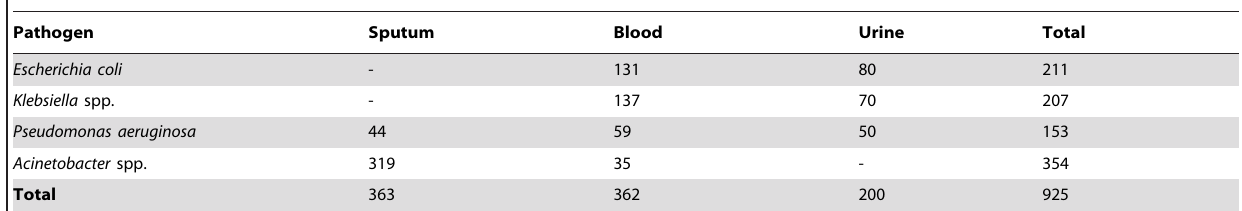
Table 1. Pathogens by source of isolation.